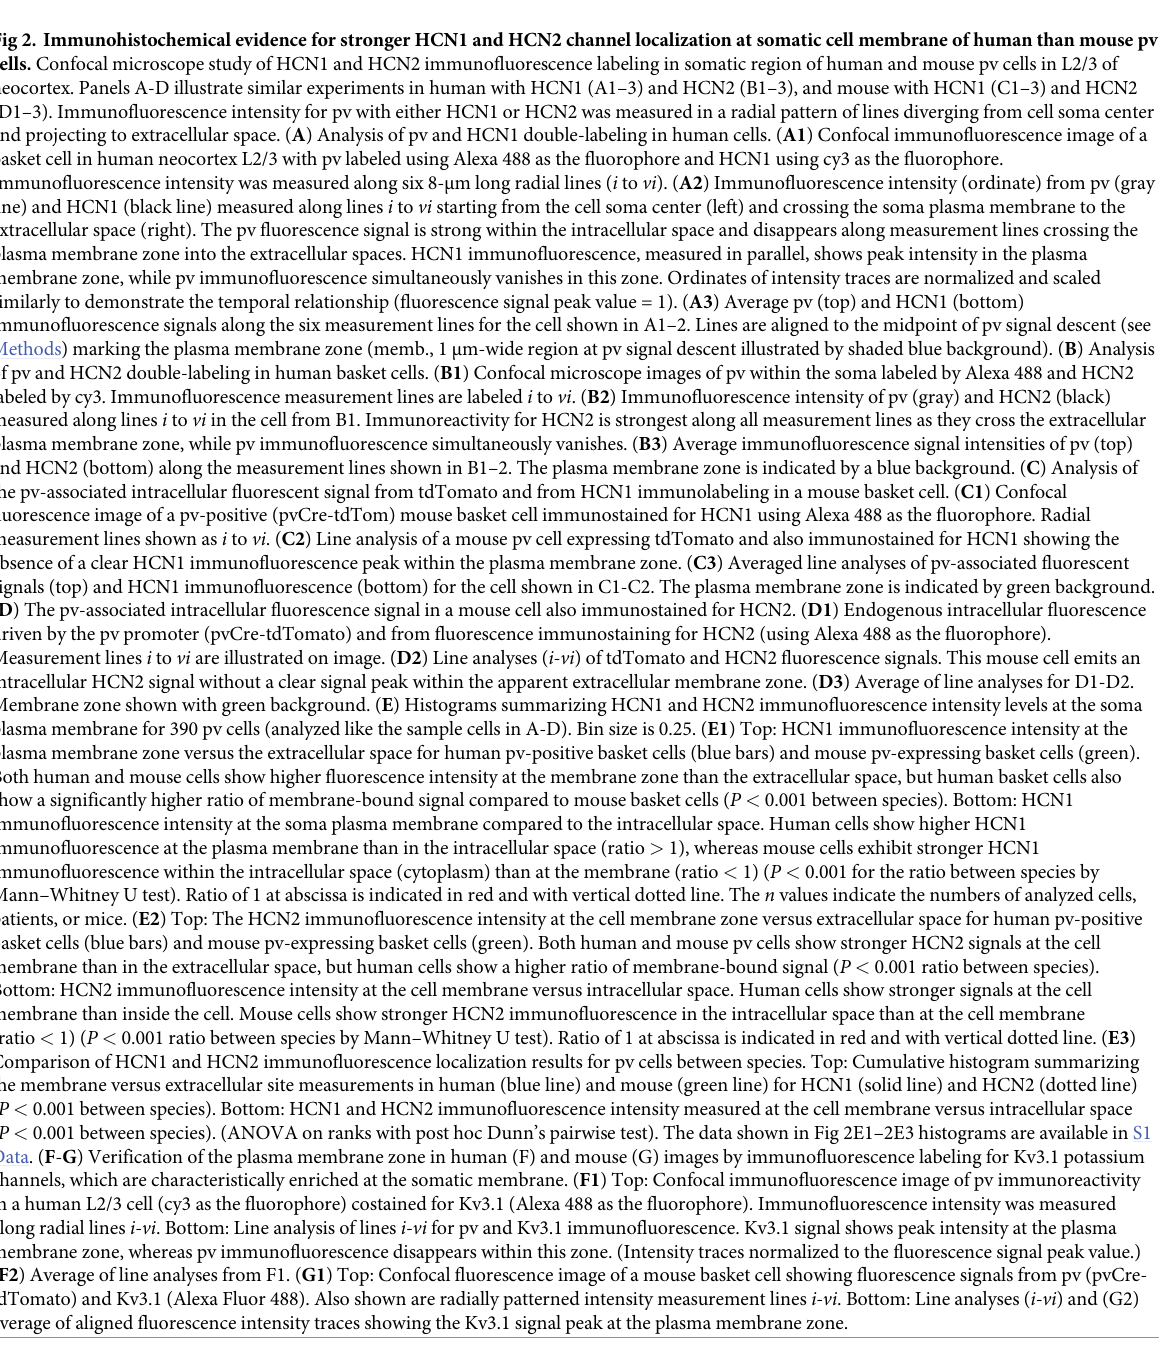
and cytoplasm. In line analysis, the plasma membrane area appeared as a narrow zone where pv (or tdTomato) fluorescence signal rapidly disappeared (Fig 2A2–2A3). The immunofluo- rescence intensities of labeled HCN1 and HCN2 channels were measured along with the intra- cellular marker signal and were quantified in the cytoplasm, at the somatic membrane zone (defined as a 1- μ m wide region where intracellular signal disappeared; see Methods for details), and in the extracellular space (defined by the absence of intracellular signal), as illustrated in